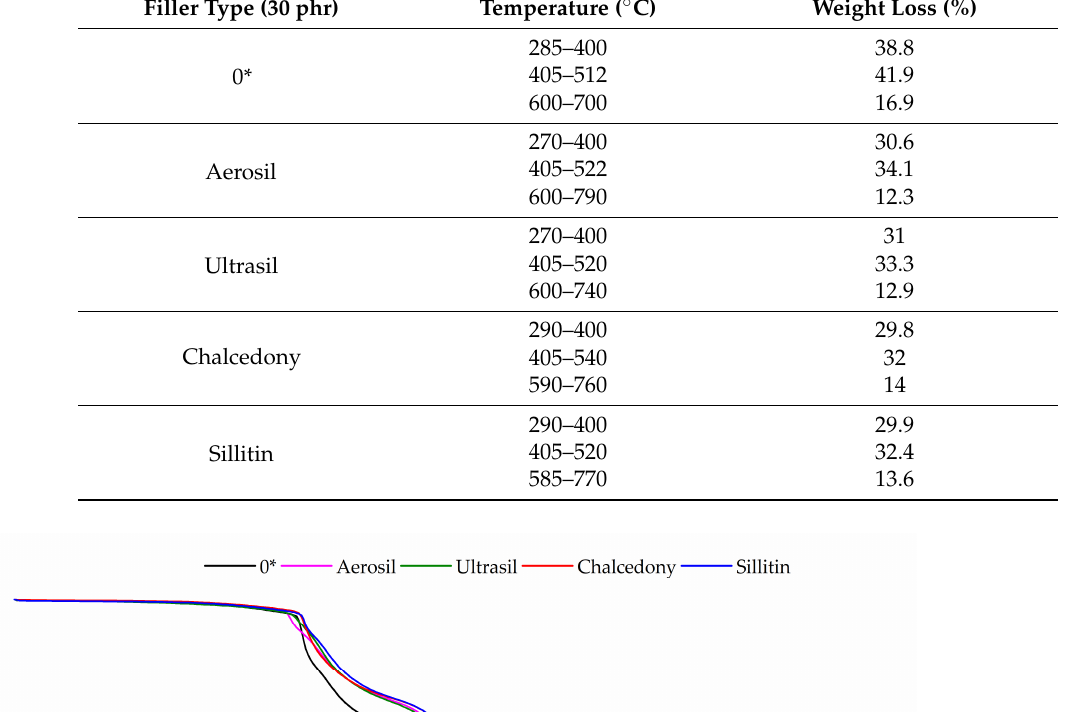
Table 10. Thermal stability of unfilled and filled CR/BR/nano-Fe 2 O 3 vulcanizates.